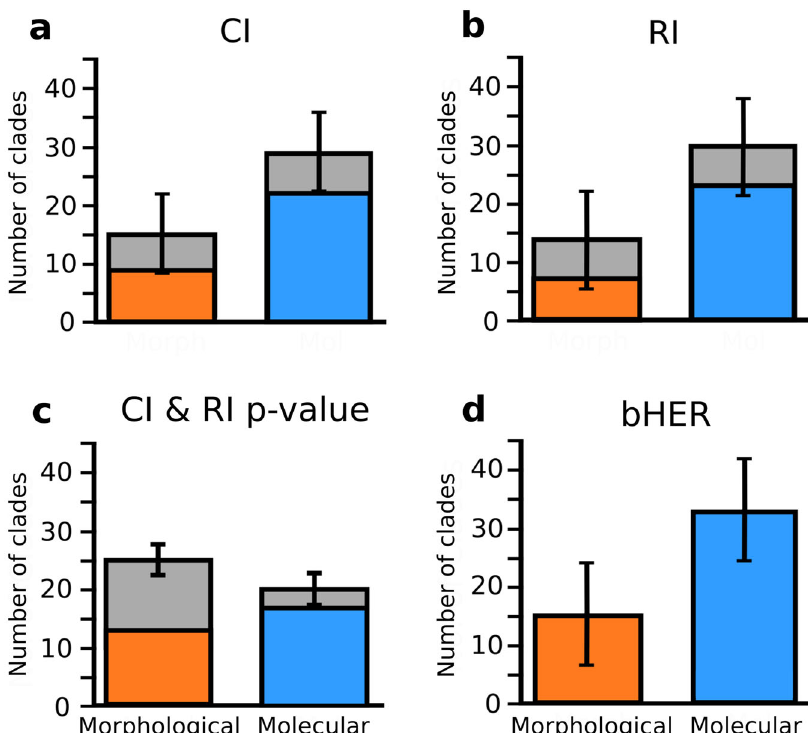
Fig. 4 The number of morphological and molecular trees most congruent with biogeography. Comparison of the number of trees in each sample (morphological or molecular) with a greater biogeographic fi t than its counterpart. a Consistency index (CI), grey bars show totals for the whole sample, coloured bars indicate totals in the subset signi fi cantly different from the expected null (CI & RI p value < 0.05). b Retention index (RI), grey bars show totals for the whole sample, coloured bars indicate totals in the subset signi fi cantly different from the expected null (CI & RI p value <0.05). c P values for the CI & RI random permutations (CI & RI p value), where grey bars show totals for the whole sample, coloured bars are clades with values <0.05. d biogeographic HER (bHER), counts are for the whole dataset. Bars show the number of clades in each subset, with binomial con fi dence intervals calculated using the approach of Clopper and Pearson 103 . N = 48 biologically independent pairs of morphological and molecular